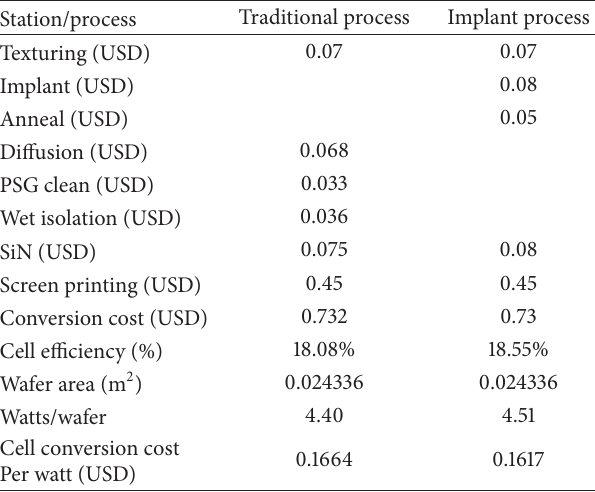
Table 7: The cell conversion cost per watt of traditional and implant processes on quasi-mono wafer